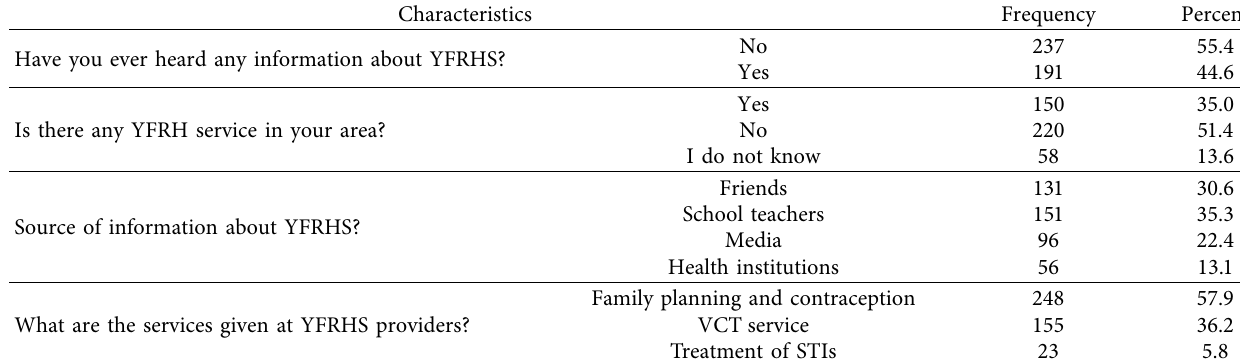
Table 2: Knowledge of youth-friendly service among students of MTU-Tepi campus, 2019 ( n � 428).